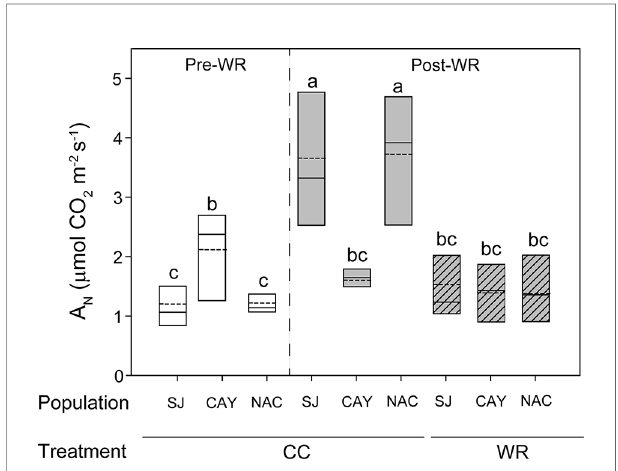
FIGURE 3 | Signi fi cant triple interaction between measurement time, population, and water restriction treatment affected net photosynthesis (A N , µmol CO 2 m -2 s -1 ) in Persea lingue plants. Bottom and top boundaries of the boxes represent the 25 th and 75 th percentiles, respectively. The solid line in the center of each box represents the mean value and the dashed line represents the median value. Different letters indicate signi fi cant differences among measurement time, populations, and water restriction treatment according to Tukey at p<0.05. Pre-WR, measurement before the onset of water restriction; Post-WR, measurement at end of experiment; CC, container capacity; WR, water restriction; SJ, Santa Juana; CAY, Cayumanque; NAC.